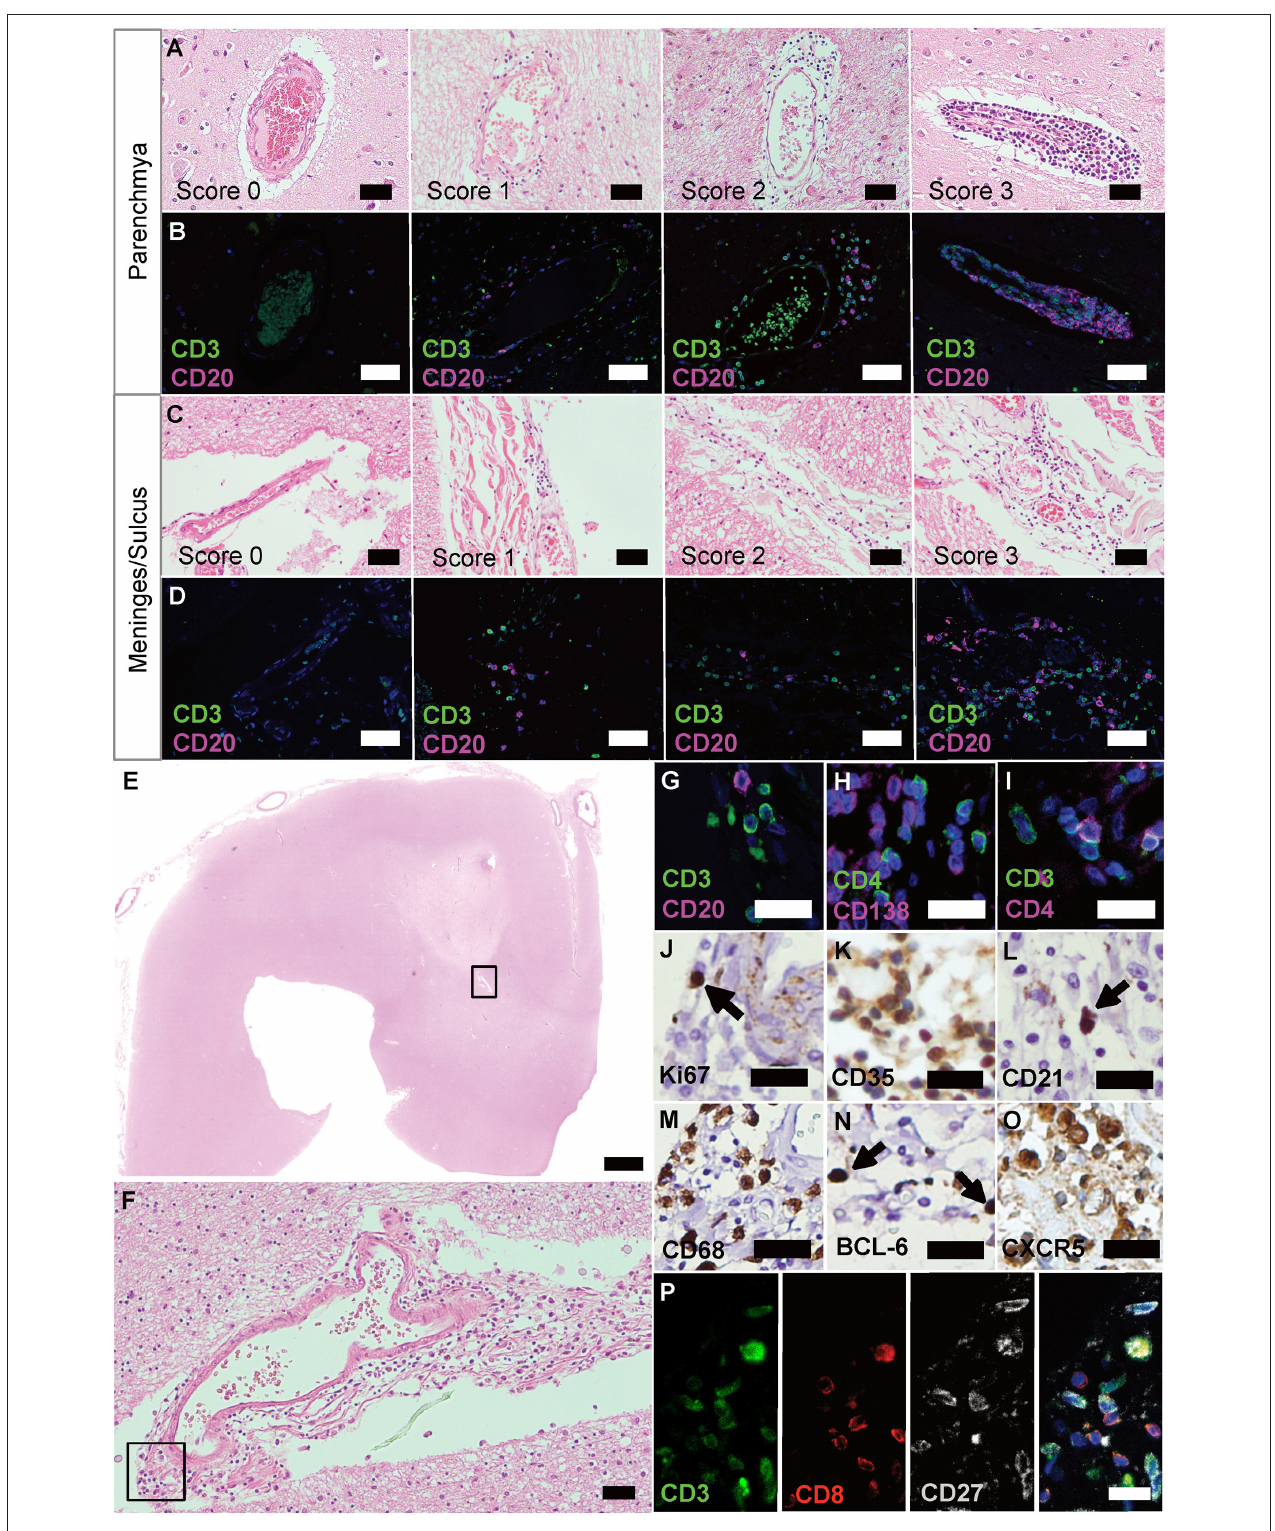
FIGURE 1 | Ectopic lymphoid structures in progressive MS are characterized by infiltration of lymphocytes, FDCs and plasma cells. (A) Parenchyma of FFPE sections of brain and spinal cord of progressive MS patients were screened for infiltrated regions by H&E staining. (B) IF staining for CD3 + T cells and CD20 + B cells on serial